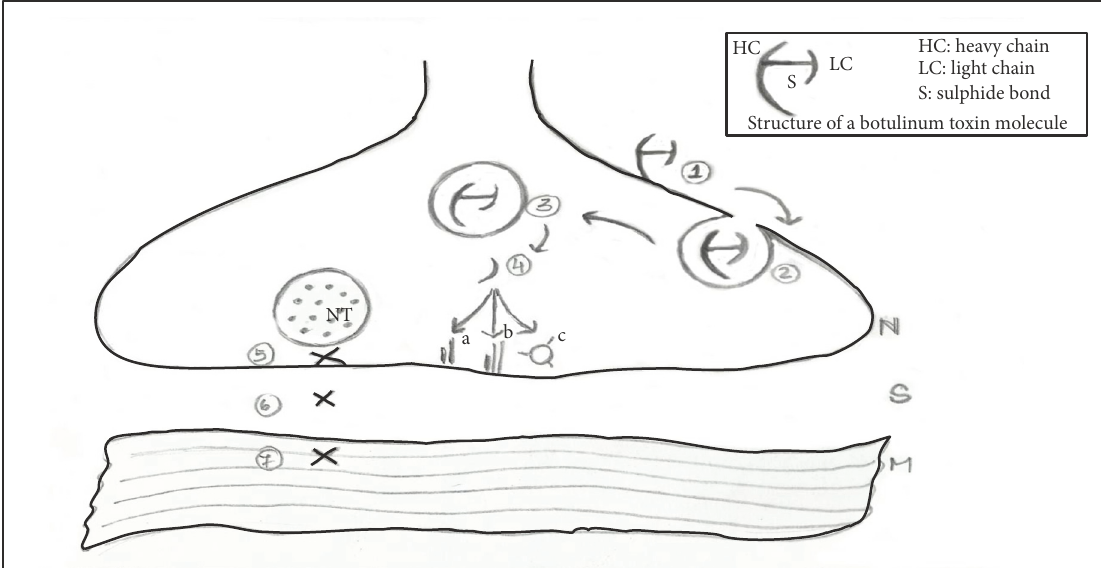
Figure 8: Mechanism of action of botulinum toxin